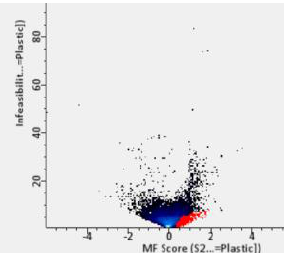
Figure 5 . Values of high Matched Filtering (MF) Score and low Infeasibility (indicated by red dots) for Plastic Class of October 5, 2019 Satellite Image.